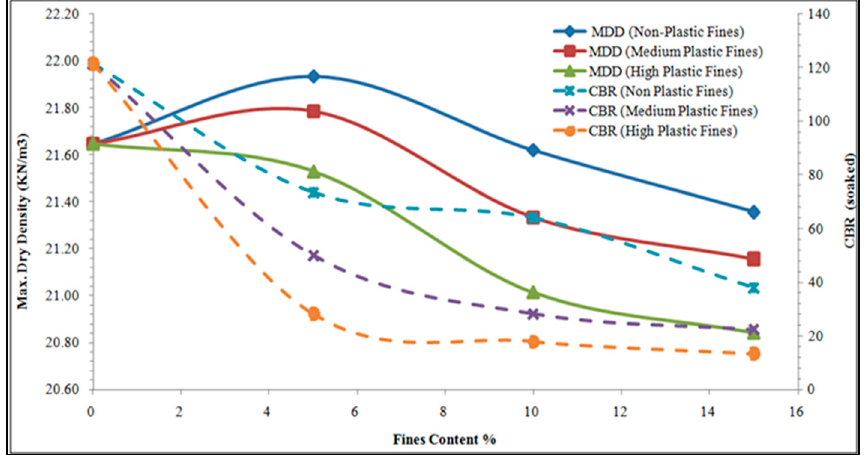
Figure 4. Effect of fines on the MDD and CBR values for the composite samples (gradation B).